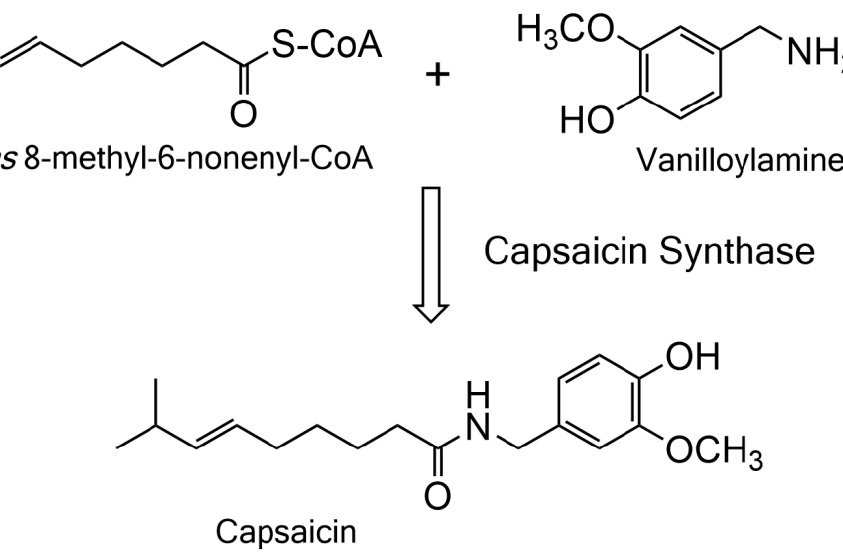
Figure 1. Reaction catalyzed by capsaicin synthase in chili peppers. An amide bond is formed between trans 8-methyl-6-nonenoyl-CoA and vanilloylamine by capsaicin synthase, a BAHD-type acyltransferase.